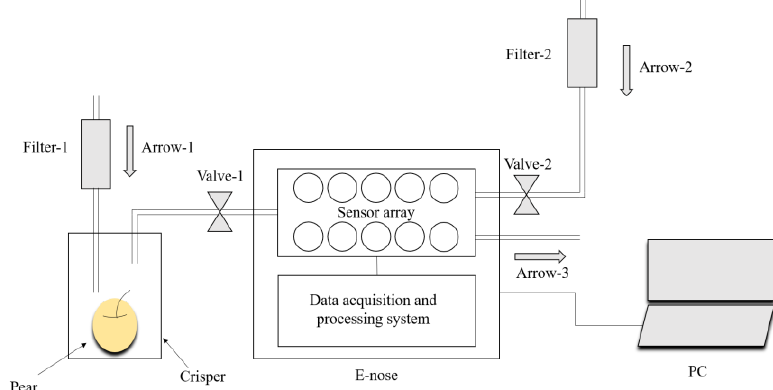
Figure 1. Schematic diagram of the sample collection using E-nose.